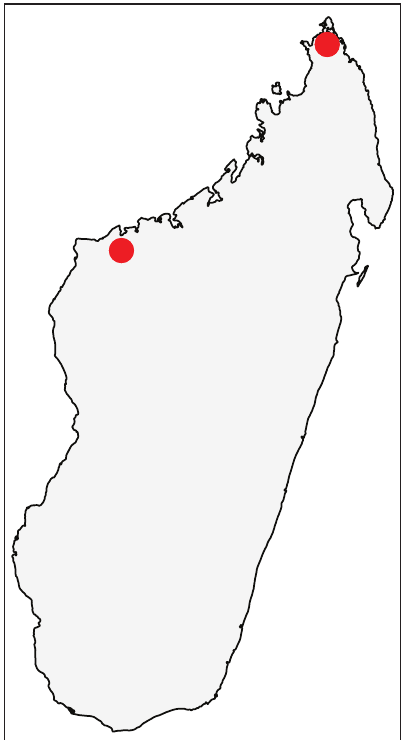
Figure 33. Geographic distribution of Nesomyrmex longiceps sp. n.. The known localities of N. longiceps sp. n. in